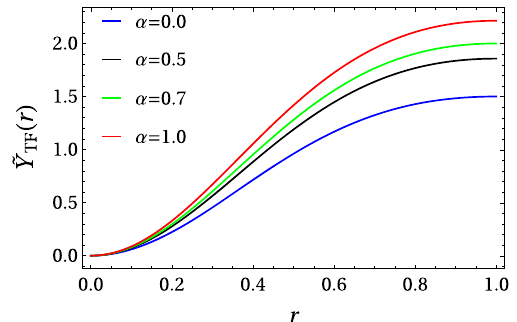
Fig. 3 Complexity factor [ ˜ Y TF × 10] for different values of the param- eter α starting from the Tolman IV isotropic solution ( α = 0)